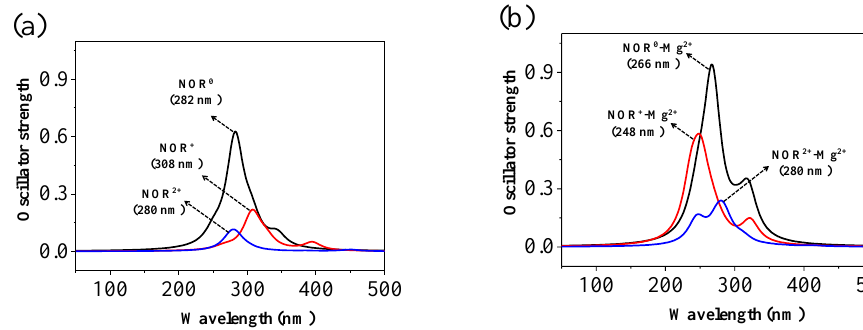
Figure 3. Calculated electronic absorption spectra of ( a ) NOR and ( b ) complexes NOR-Mg 2+